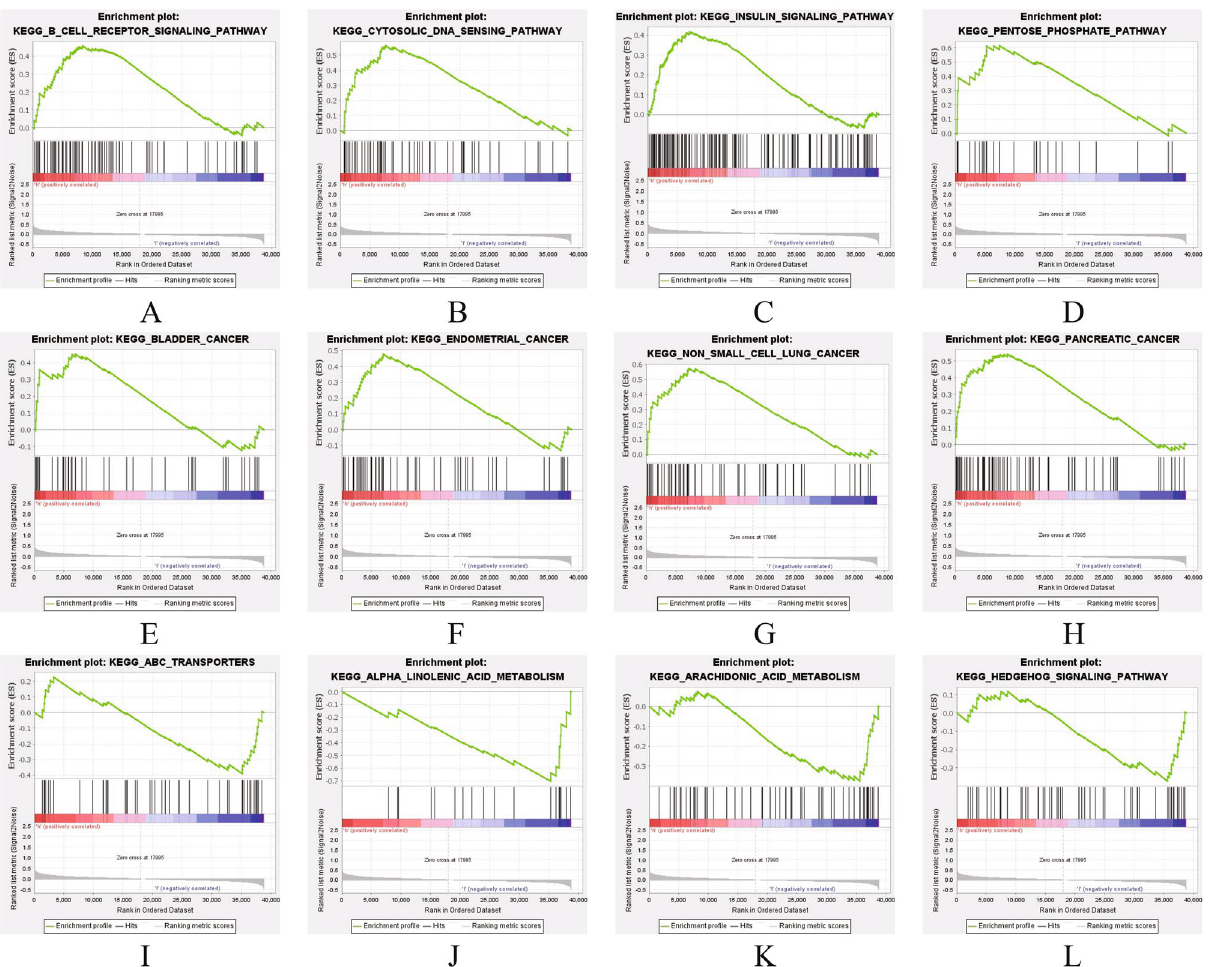
Figure 7. GSEA of M7G high expression ( A–H ) and low expression ( I–L )